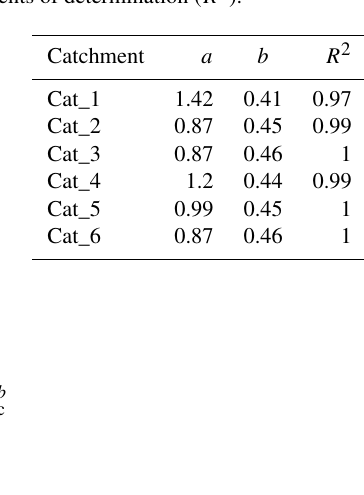
Table 2. Coefficients of the power relation between D m and A c and the coefficients of determination ( R 2